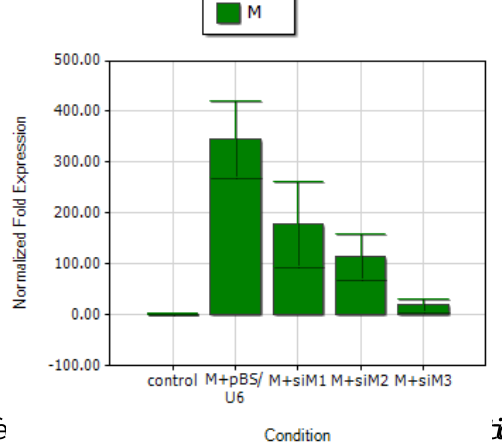
Figure 5. Comparison of the inhibitory effect mediated by si-M1, si-M2 and si-M3 on M gene expression by qRT-PCR analysis. About 2  g of M gene was co-transfected with 4  g of each plasmid pBS/U6, si-M1, si-M2 and si-M3, while co-transfection of 2  g of pCMV-Myc plus 4  g of pBS/U6 was served as negative control. Both  -actin-R and SARS-M-R primers were used in this analysis.